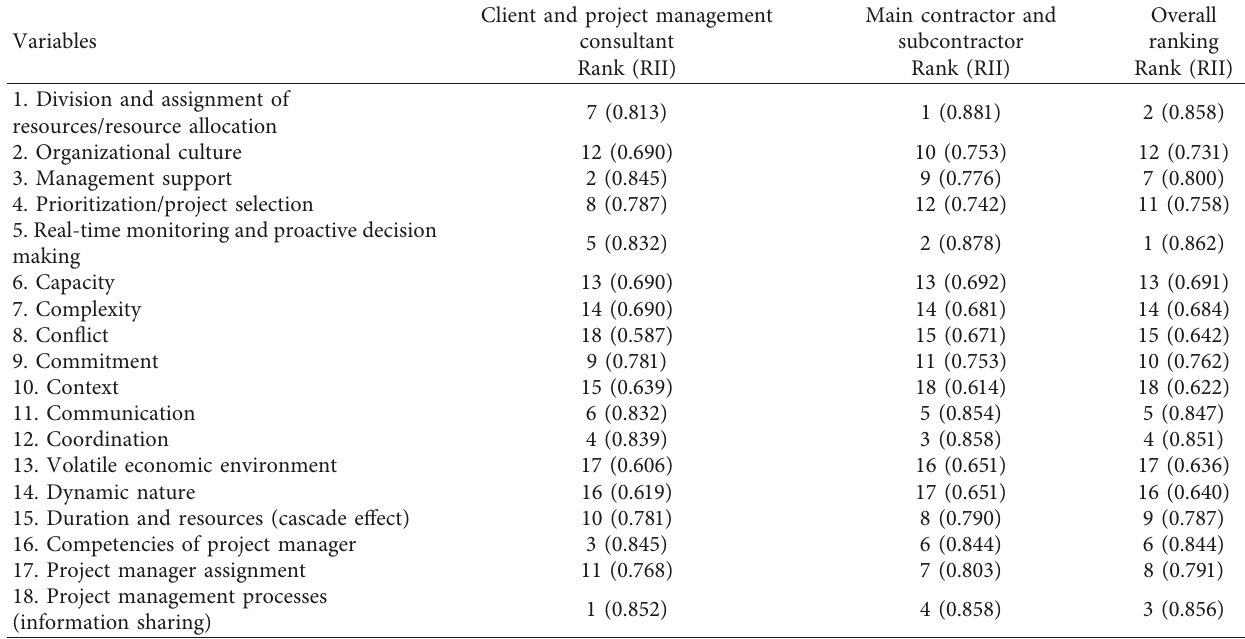
Table 3: Ranking of challenges in managing the multiproject environment